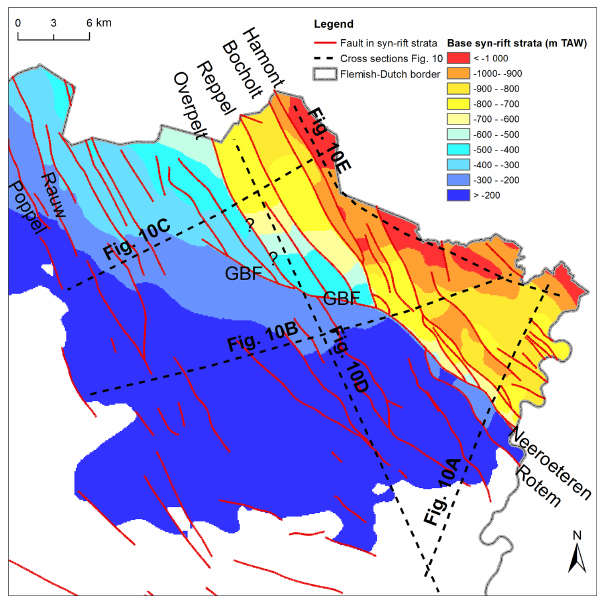
Figure 7. Map showing the depth of the base of the syn-rift strata and the syn-rift faults in the study area from the G3Dv3 model. The locations of the cross sections in Fig. 10 are also indicated. Question marks indicate uncertainties in the fault trace.